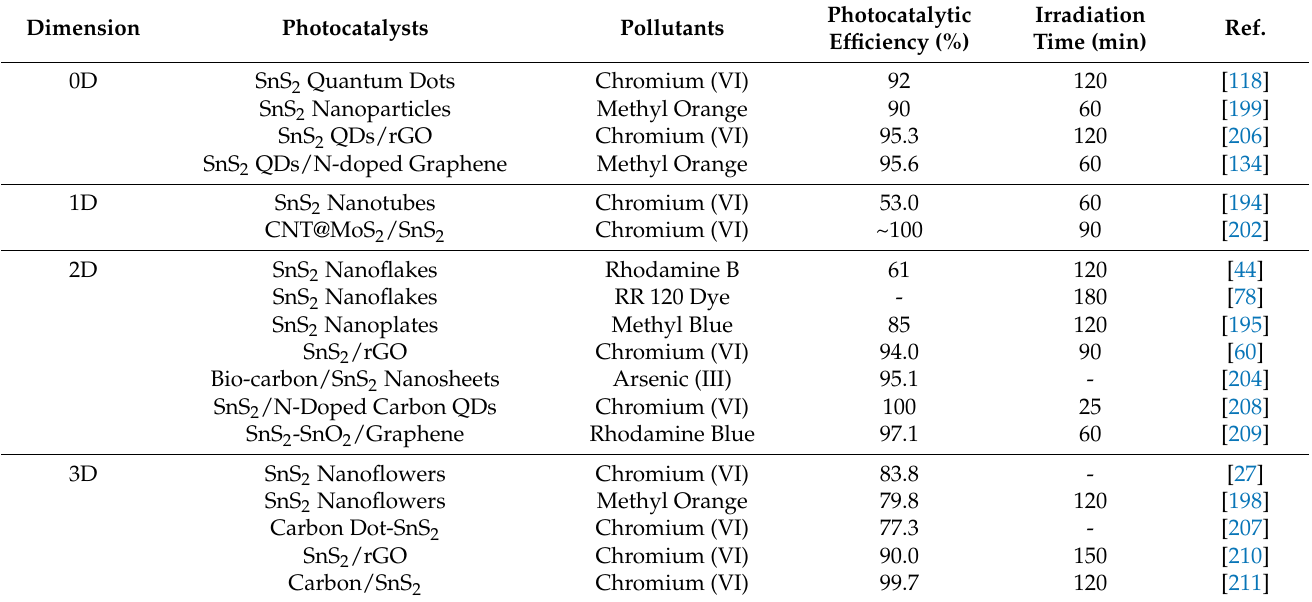
Table 3. Comparison of the photocatalytic activity of SnS 2 and SnS 2 /Carbon nanomaterials on pollutant